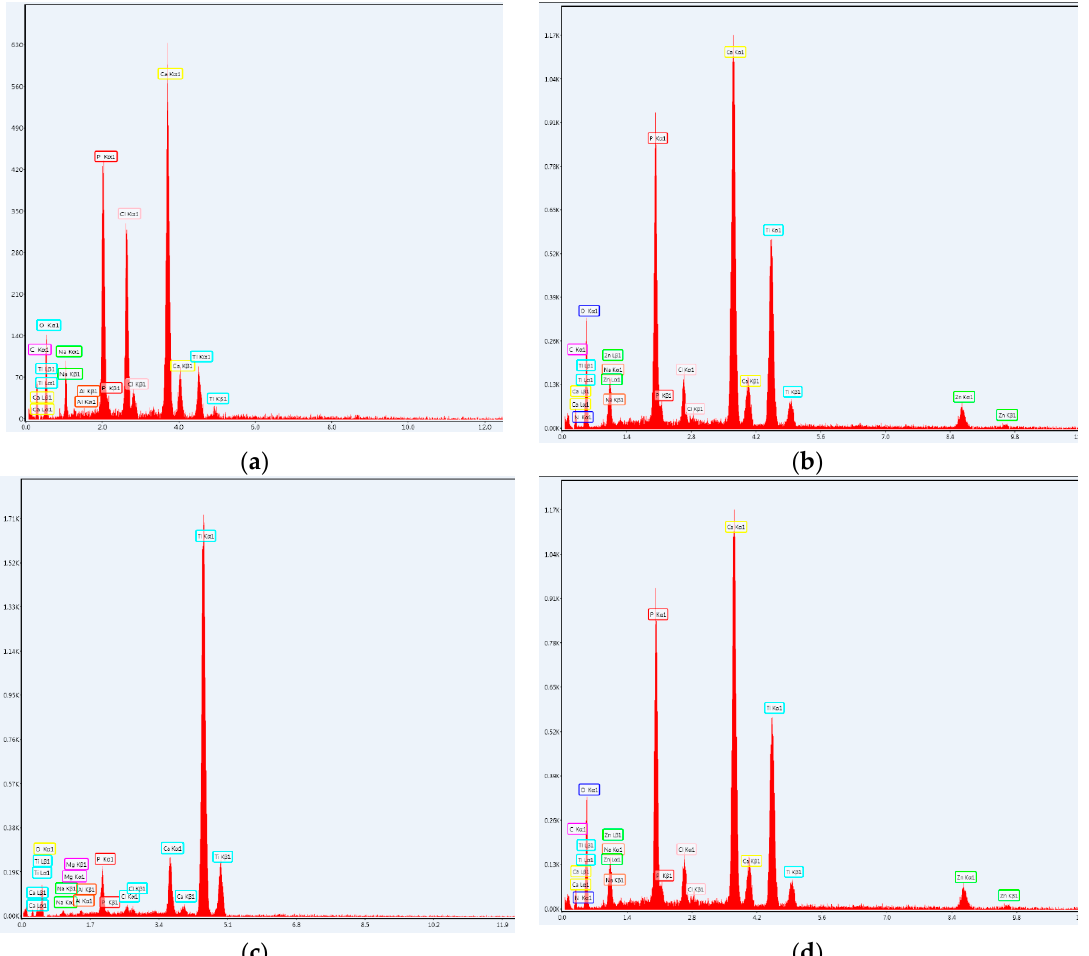
Figure 9. Energy dispersive spectrometer (EDAX), spectra of the Coll/CaPs thin films with 0 wt% and 1 wt% Zn(II) deposited by ( a ), ( b ) Spin coating and ( c ), ( d ) MAPLE after 14 days of immersion in SBF.